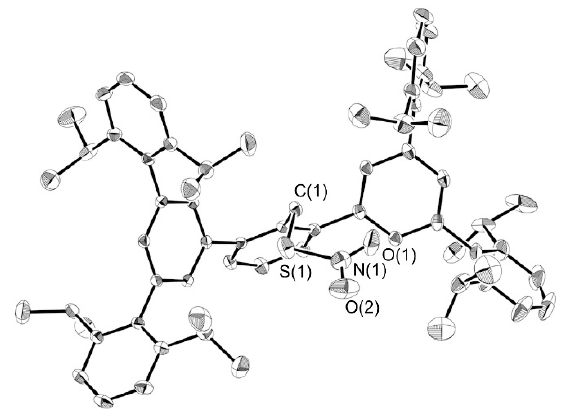
Figure 2. Oak Ridge thermal ellipsoid plot (ORTEP) drawing of 6 (50% probability). Table 1. Selected bond lengths and angles for thionitrates.